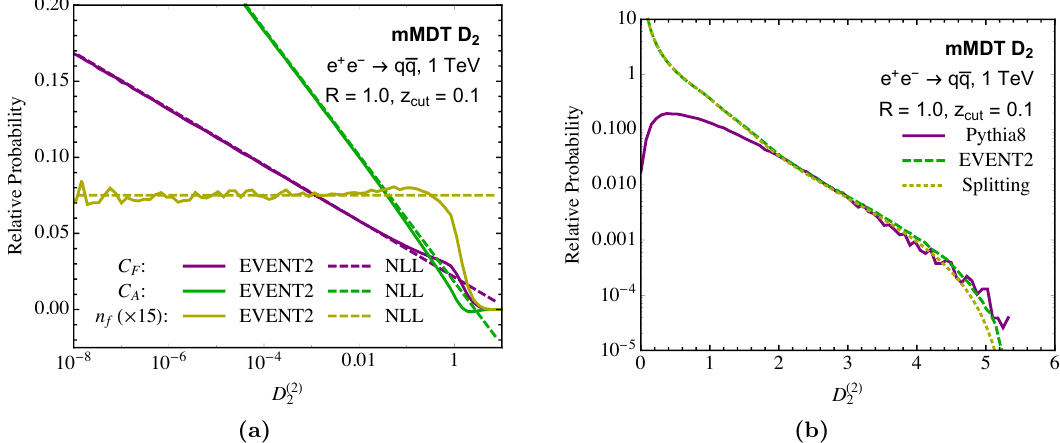
Figure 12. (a) A comparison of the NLL prediction expanded to (cid:12)xed order with EVENT2 . The singular behavior of the D 2 distribution is reproduced by our factorization. (b) Comparison of the end-point value found by (cid:12)xed-order codes and Monte Carlo event generators. Note the robustness of the endpoint set by z cut even in the prescence of multiple